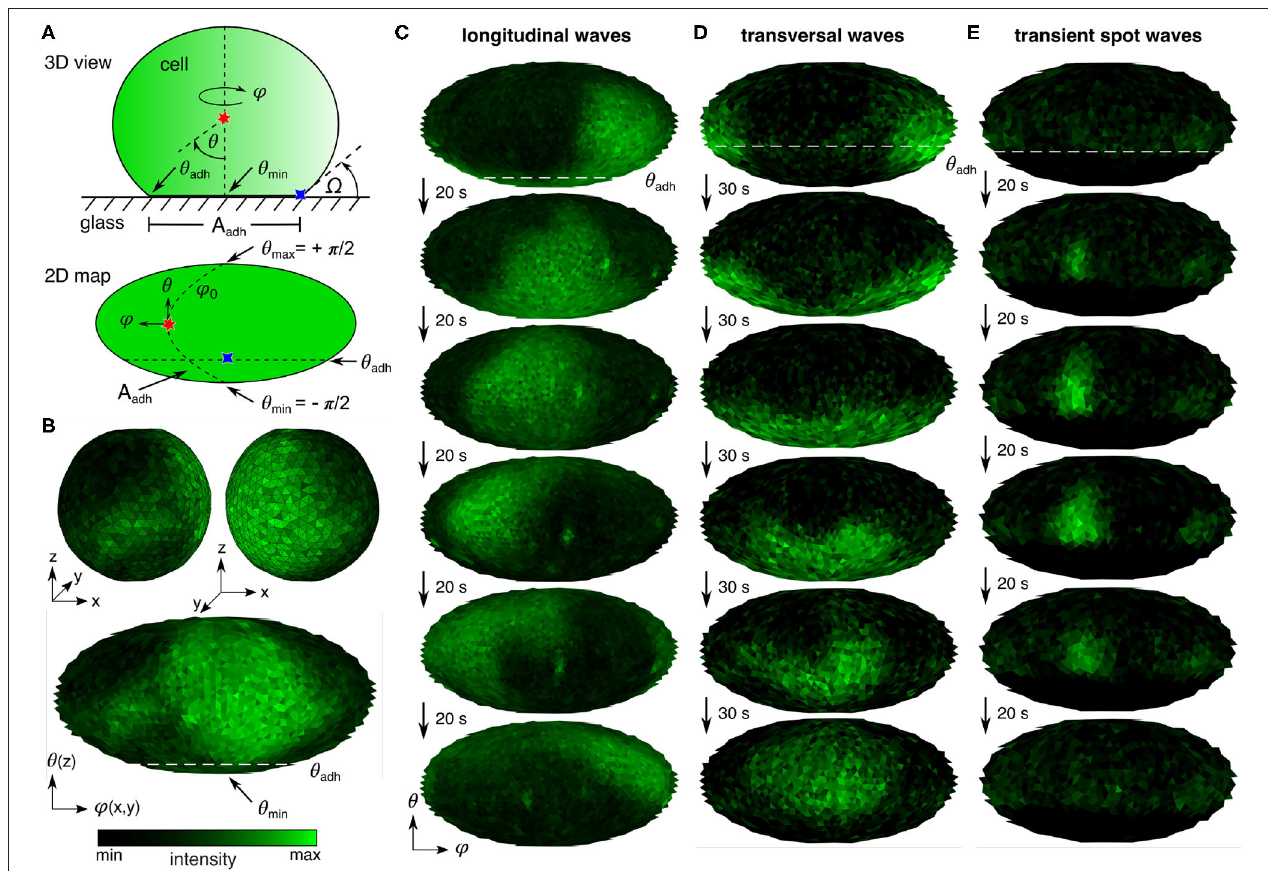
FIGURE 1 | PIP3 domain dynamics on Dictyostelium cells. (A) Scheme of actin polymerization-inhibited cell attached to glass surface: 3D view and 2D map. Indicated are spherical coordinates, the periodic azimuthal angle φ (horizontal) and polar angle θ (vertical), the positions of θ at the center of ventral membrane θ min the contact perimeter θ adh , the contact angle (cid:127) , and the area of the ventral membran A adh . (B) 3D visualization of entire membrane PIP3 signaling. The upper two panels show the front and back side of a cell. The lower panel shows the corresponding 2D map (Mollweide projection, see Materials and Methods) of the entire membrane signaling. (C,D) Examples of the basic PIP3 domain dynamics. θ adh is indicated at the first map by the white dashed line. (C) Horizontal waves that propagate parallel to the contact perimeter. (D) Vertical waves that periodically cross the contact perimeter. (E) Transient spot waves that appear and disappear repeatedly above the contact